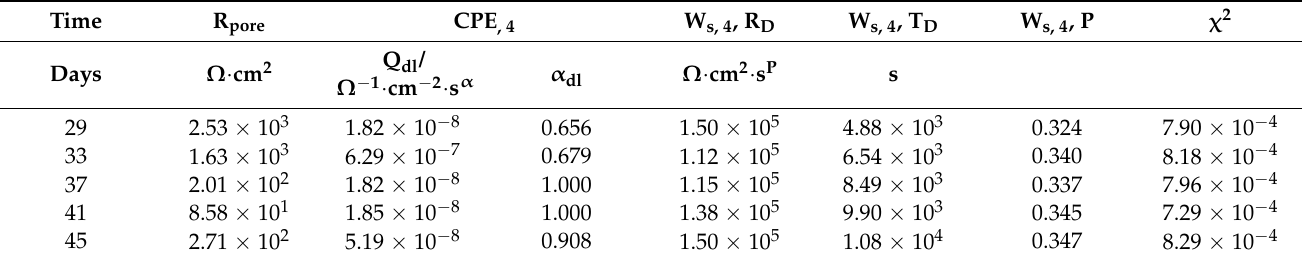
Table 7. Fitted values of EEC components for a coating prepared from the formula Zn–80%-PC, Stage 4.